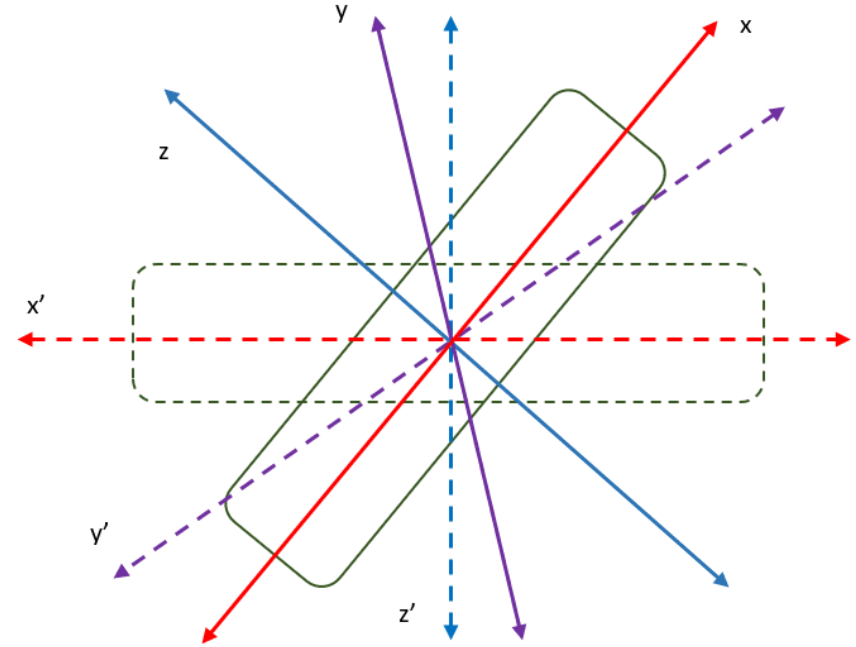
Figure 2. The orientation of the laying data (dotted line) after the multiplication with rotation matrix from unoriented position (solid line).